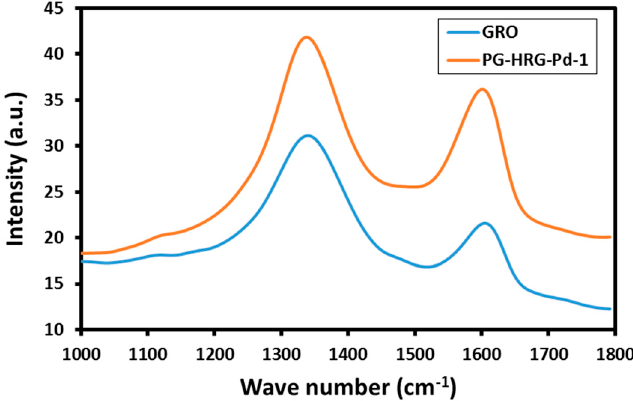
Figure 3. Raman spectra of graphene oxide (GRO) and plant extract ‐ mediated Pd@graphene nanocatalyst (PG ‐ HRG ‐ Pd ‐ 1).